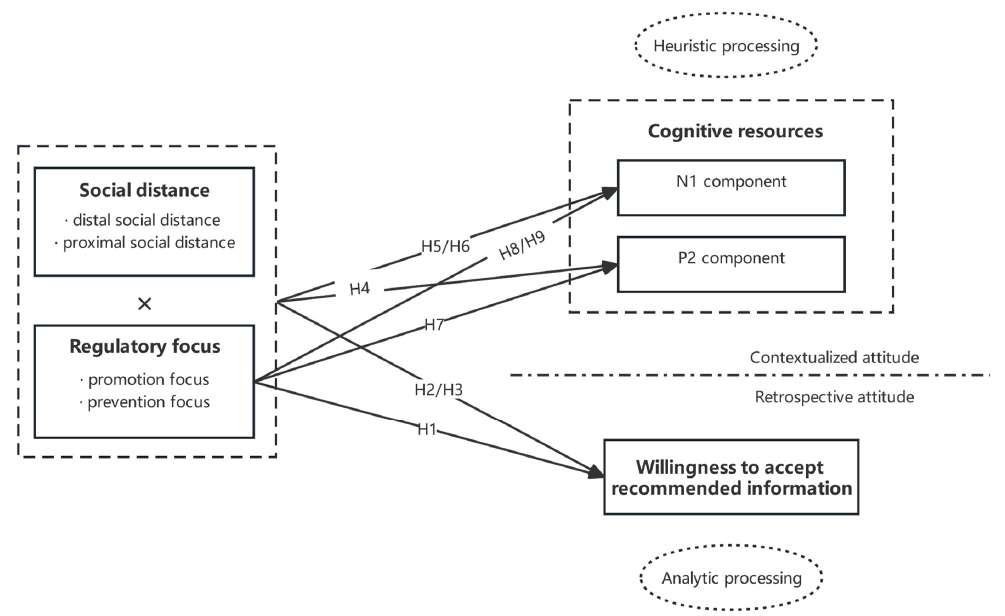
Figure 1. Research